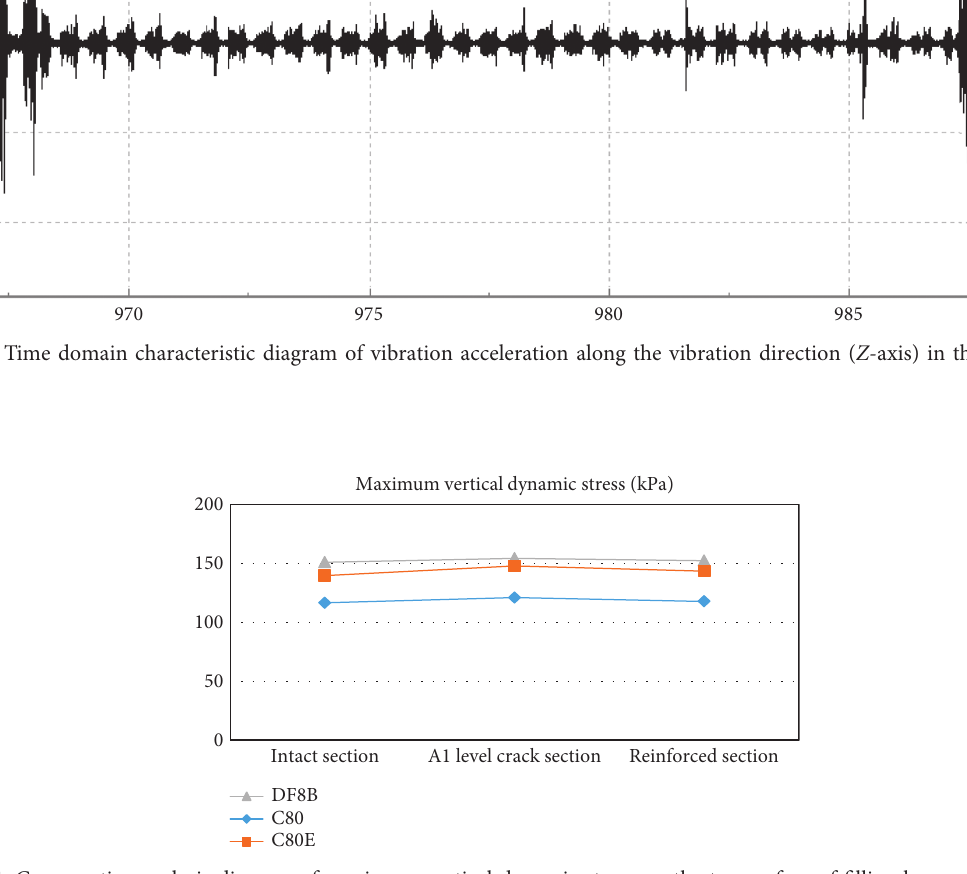
Figure 24: Comparative analysis diagram of maximum vertical dynamic stress on the top surface of filling layer under the rail.